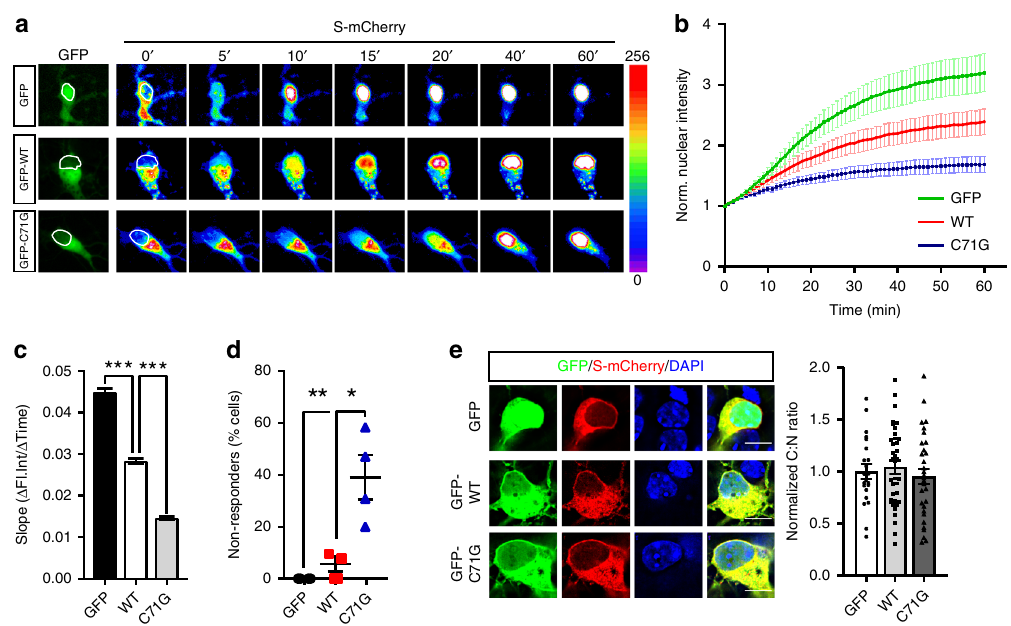
Fig. 4 Mutant PFN1 alters the ef fi ciency of nuclear import. a , b Time-lapse images and quanti fi cation of S-mCherry nuclear import dynamics in cortical neurons expressing GFP or GFP-tagged PFN1 (green) and treated with LMB. S-mCherry levels are shown as 16-bit heat map. Dashed lines indicate the nucleus. c , d Regression analysis of S-mCherry nuclear import kinetics ( c ) and percentage of cells whose nuclear levels did not rise above 1.2 folds over initial values upon the application of LMB (i.e., non-responders, d ). e S-mCherry (red) C:N ratio is not affected by mutant PFN1 (green) in untreated cells. GFP alone, used as control, localizes to both nucleus and cytoplasm. DAPI (blue) was used to detect the nucleus and assess cell health. Scale bars: 10 µ m. Bars are mean ± SEM; * p < 0.05, ** p < 0.01, *** p < 0.001. N = 44 cells from 4 independent experiments ( b , c ), 4 independent experiments ( d ), 22 – 37 cells from 3 independent experiments ( e ). See Supplementary Table 1 for details on